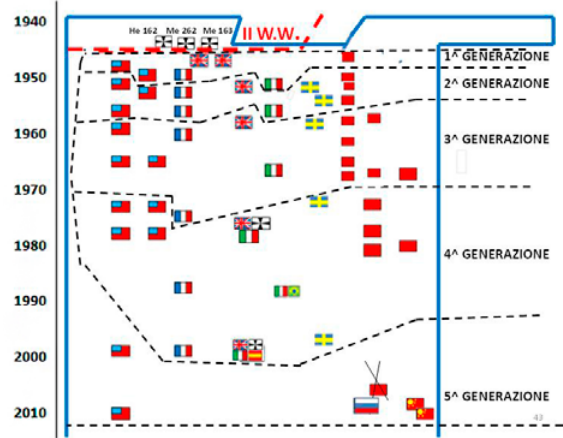
Fig. 6. Jet fighters in the context “Time-Country” Fig. 7. The 4 th generation jet fighters; architecture